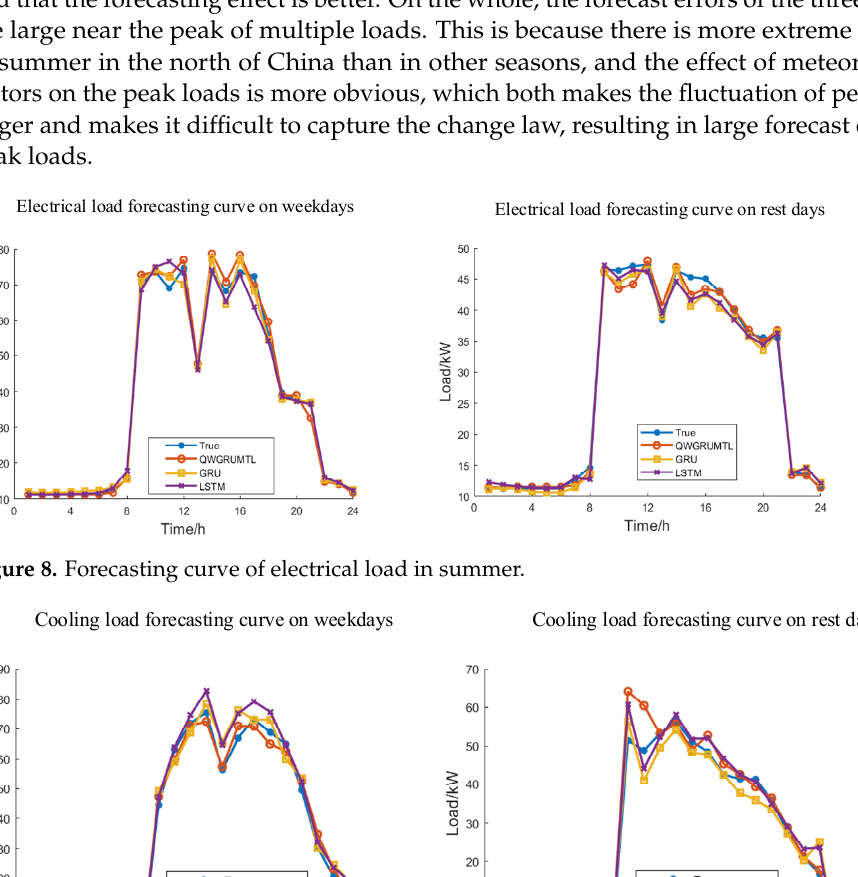
Table 3. Comparison of the effects of multi-task learning and single task learning.